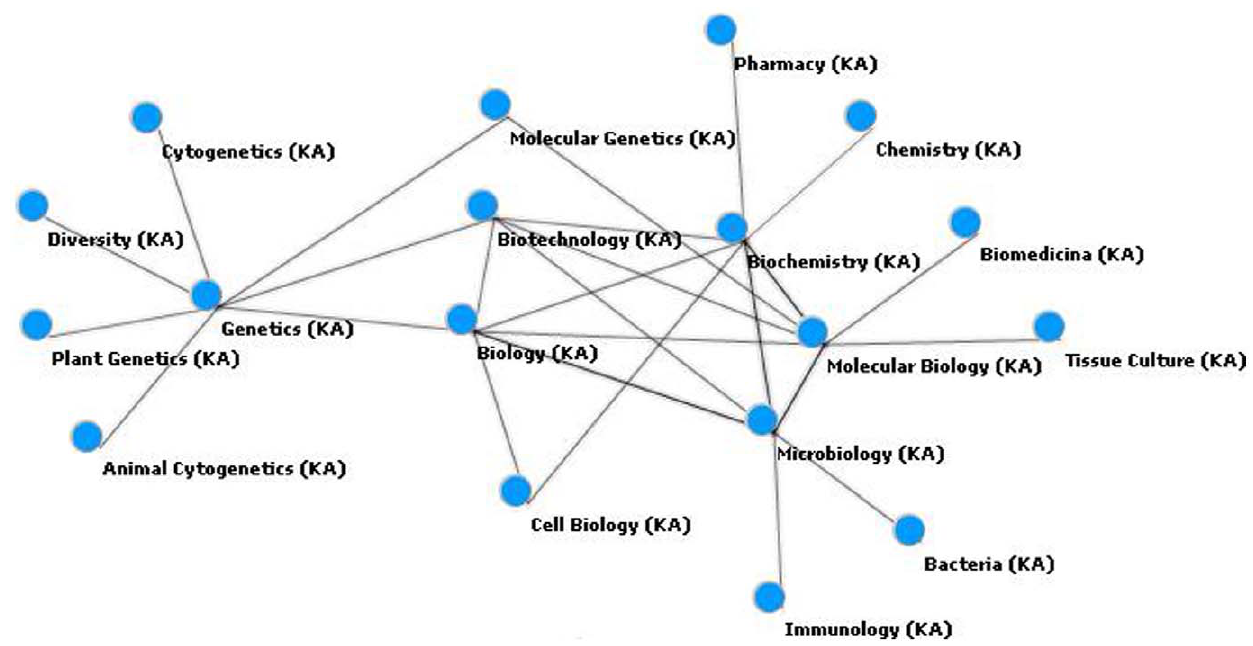
Figure 6. Specific network graphic for the biotechnology instance. doi:10.1371/journal.pone.0027499.g006 specific number of levels the network should depict’. Level indicates the network depth.